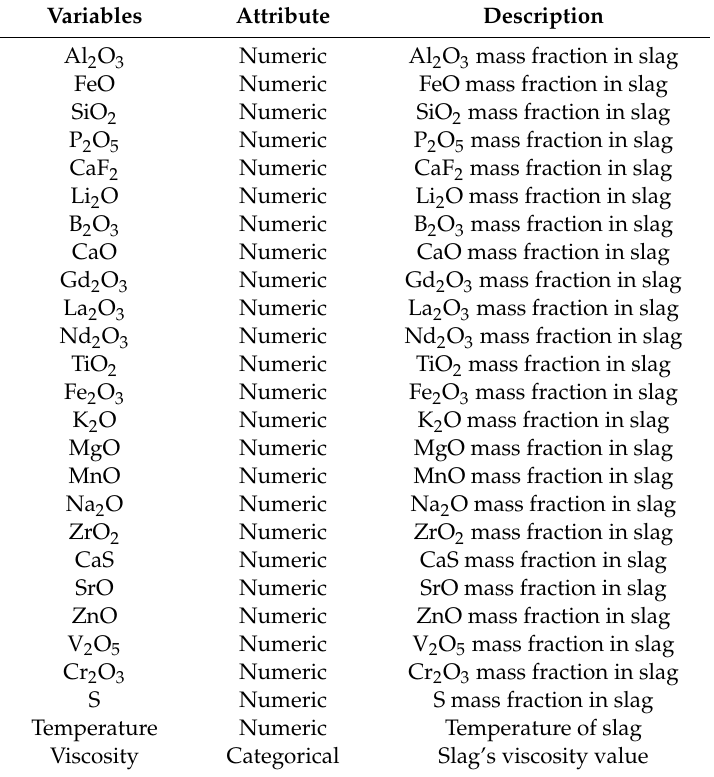
Table 1. Variables for data